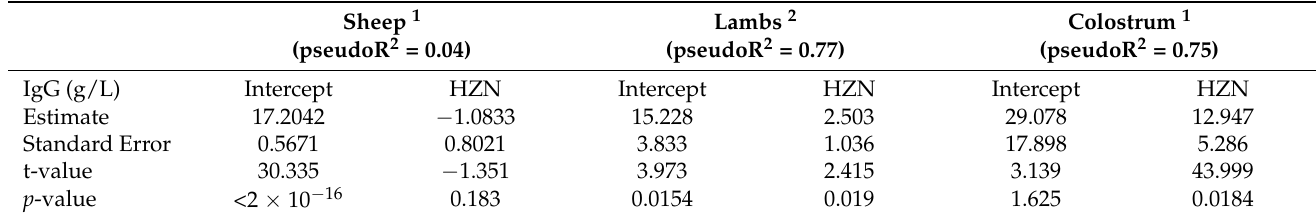
Figure 1. ( A ) IgG (g/L) concentration in ewes’ serum at birth (A), 24 h (B), and 48 h (C) after lambing for control (CTR) and hazelnut skin (HZN) group. ( B ) IgG (g/L) concentration in lambs’ serum at birth (A) and 24 h (B), 48 h (C), and 10 days (D) after lambing for the control (CTR) and hazelnut skin (HZN) group. ( C ) IgG (g/L) concentration in colostrum collected at birth (A), 24 h (B), and 48 h (C) after lambing for control (CTR) and hazelnut skin (HZN) groups. Table 3. Linear mixed effect models (LMMs) for sheep, lambs and colostrum IgG concentration. Estimates, standard errors, t-values, as well as the significant level is provided for each